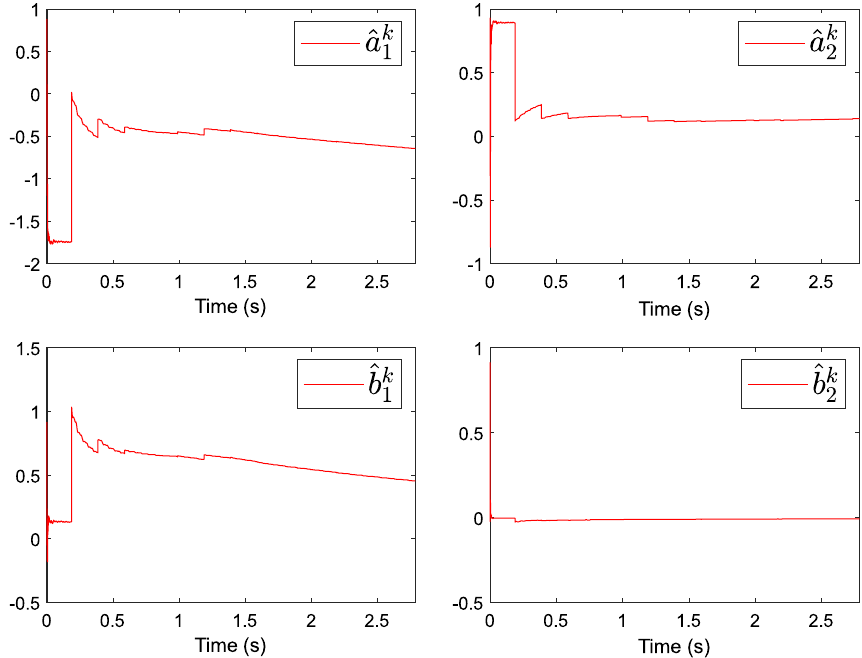
Figure 7. Convergence process of parameter estimation.